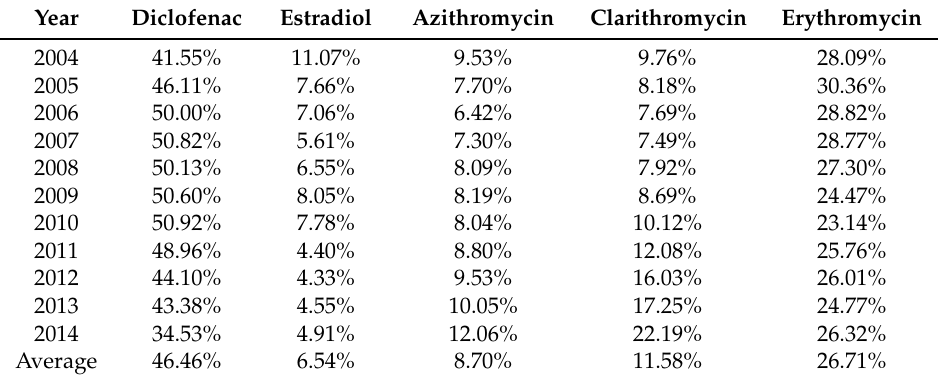
Table 2. Yearly Averages of the Percentized Hits in the Five Examined Substances in the UK from 2004 to 2014.